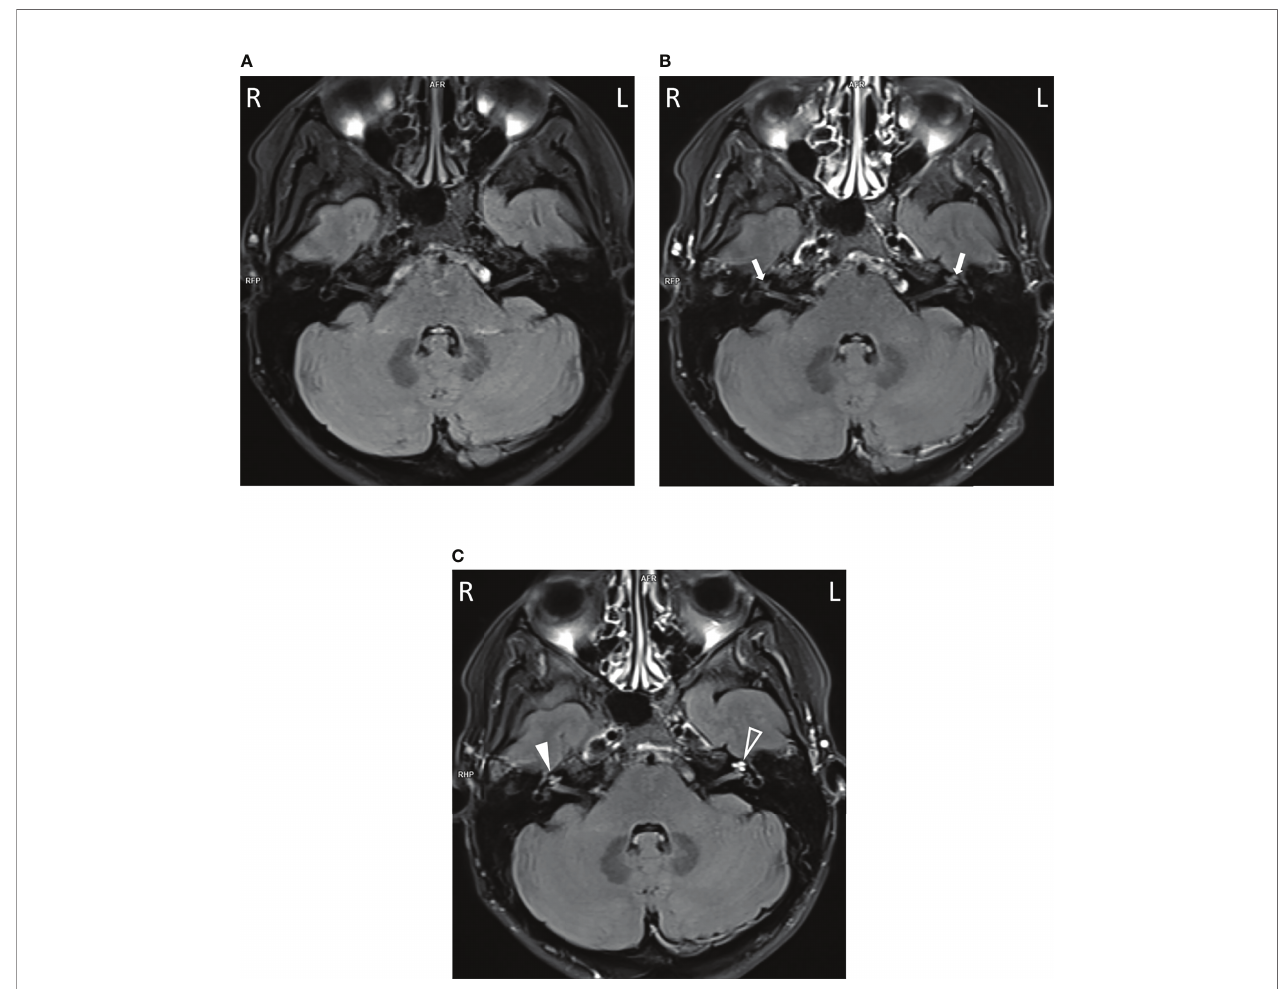
FIGURE 4 | Cochlear enhancement on FLAIR images in the proband. In comparison to non-contrast image (A) , mild cochlear enhancement (arrows) is seen on the early FLAIR image (B) . On the late FLAIR image (C) , substantial enhancement (more pronounced on the left, empty arrowhead) is observed in both cochleas